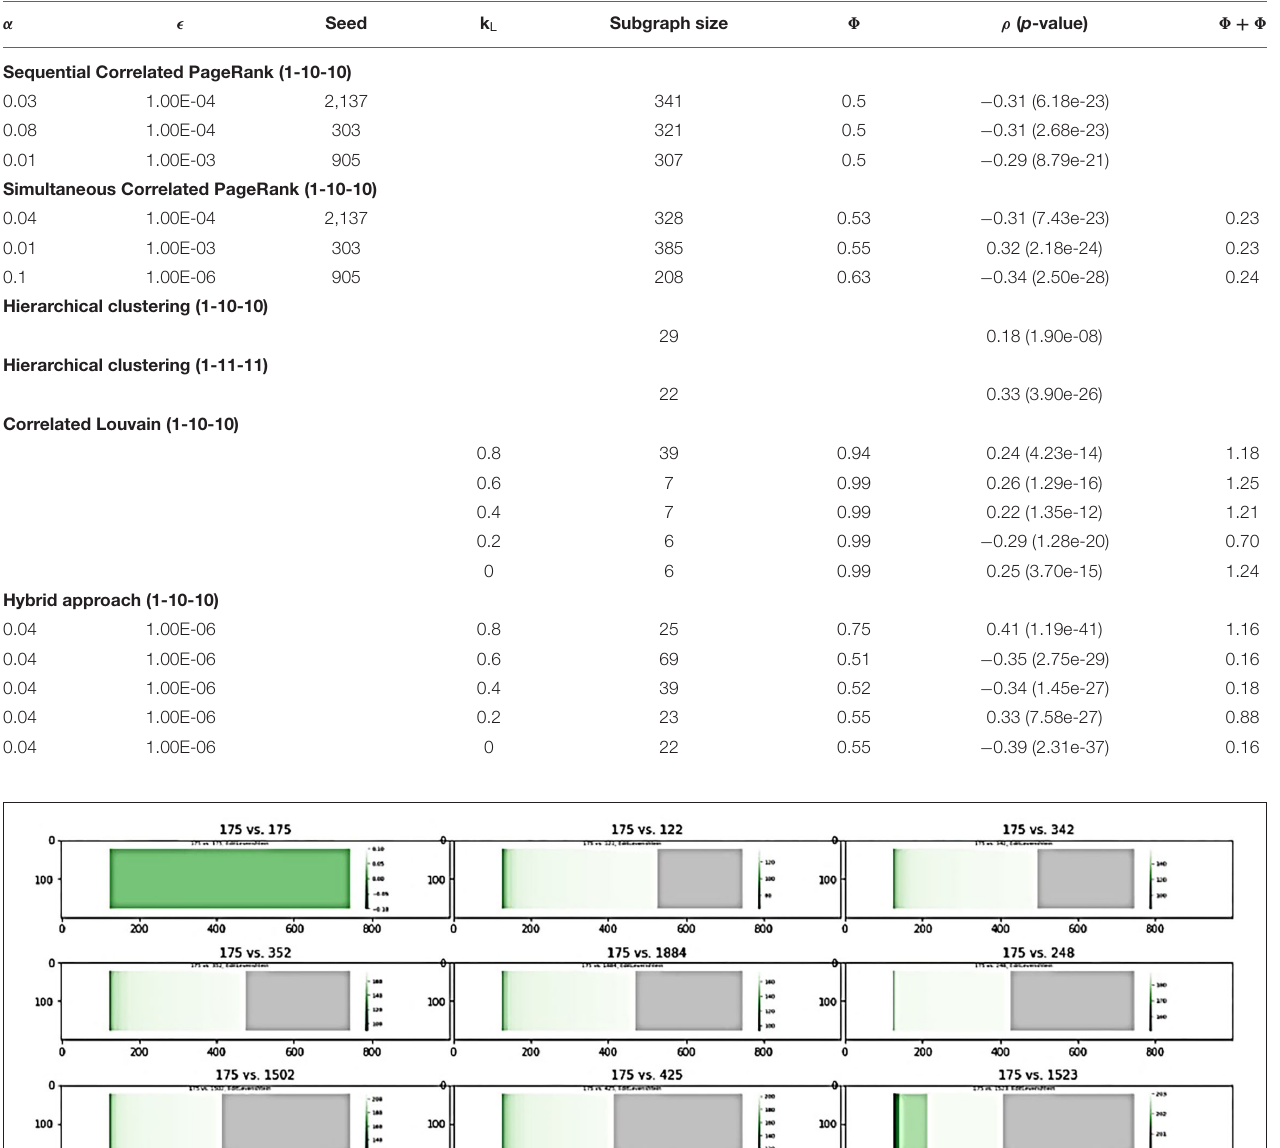
TABLE 7 | Summary of top subgraphs.